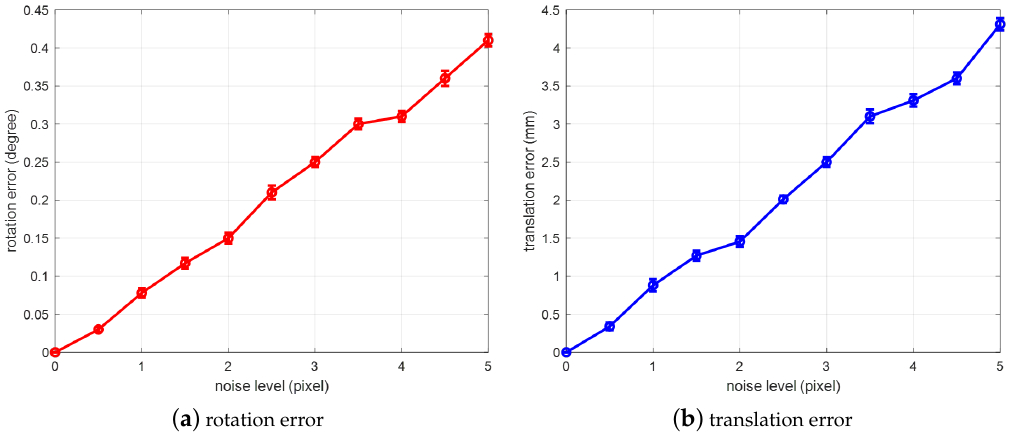
Figure 5. Influence of feature point detection accuracy on multi-view-based pose estimation: ( a ) rotation error; ( b ) translation